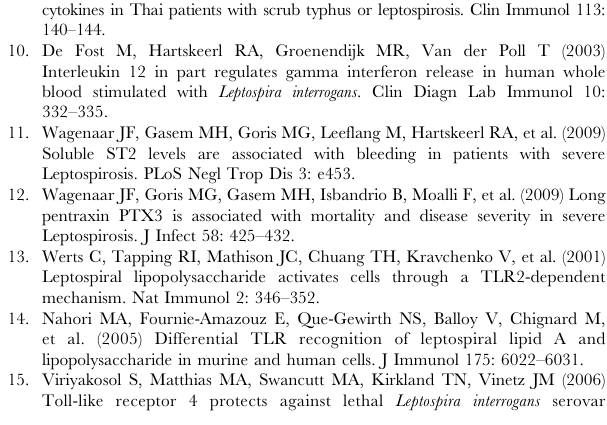
Figure S1 LigA westernblot. Westernblot of whole lysates of leptospires detected with rabbit anti-LigA antibody as follows: lane 1 contains host-adapted serovar Lai type Langkawi, lane 2 host- adapted serovar Bataviae, lane 3 reference serovar Patoc strain Patoc I. Size markers are indicated to the left. The faint band of serovar Lai type Langkawi has largely been lost by the reproductions. (TIF) Figure S2 Controls. Human whole blood stimulation with different ligands in the absence or presence of TLR-inhibiting antibodies. Concentration of the ligands are as indicated. Anti- TLR antibodies were added at the following concentrations: 2500 ng/ml anti-TLR2, 1000 ng/ml anti-TLR4 and anti-TLR5. Polymixin B (PMB), 10 m g/ml, was added to compensate effects by residual free LPS in the various ligands. Significant cross- inhibition of blocking antibodies to heterologous TLRs did not occur (not shown).